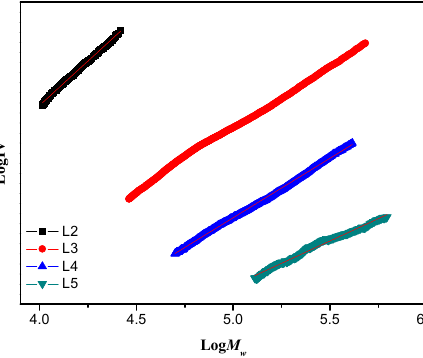
Figure 4. The plots of Log M w vs . Log ŋ (L2 α = 0.44, L3 α = 0.31, L4 α = 0.29, L5 α = 0.22).